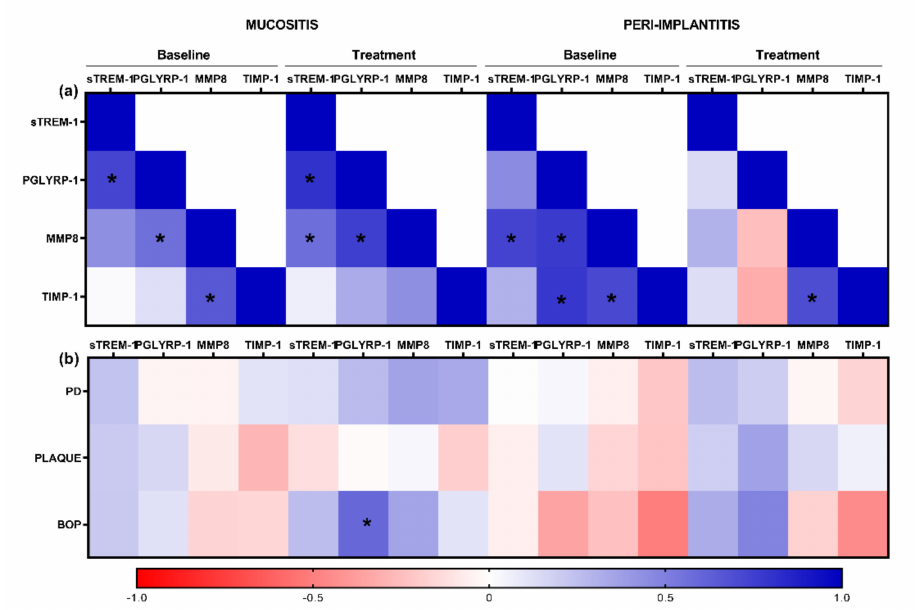
Figure 5. Heat maps exhibit correlations between the biomarkers and clinical parameters ( a ) and biomarkers ( b ) in saliva. * R ≥ 0.6, p ≤ 0.01 (Spearman correlation). PD: probing depth; BOP: bleeding on